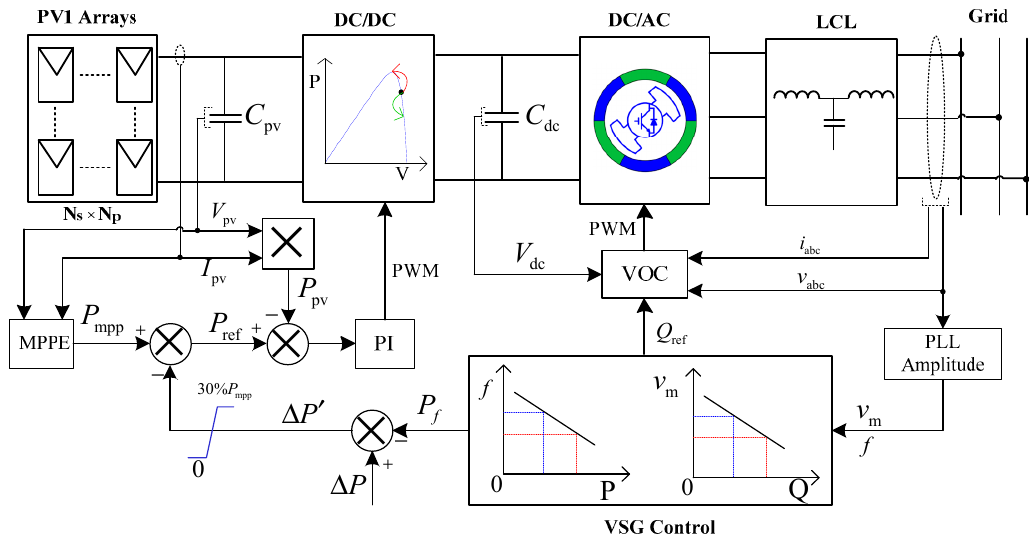
Figure 5. Principle of PRC-VSG implementation.